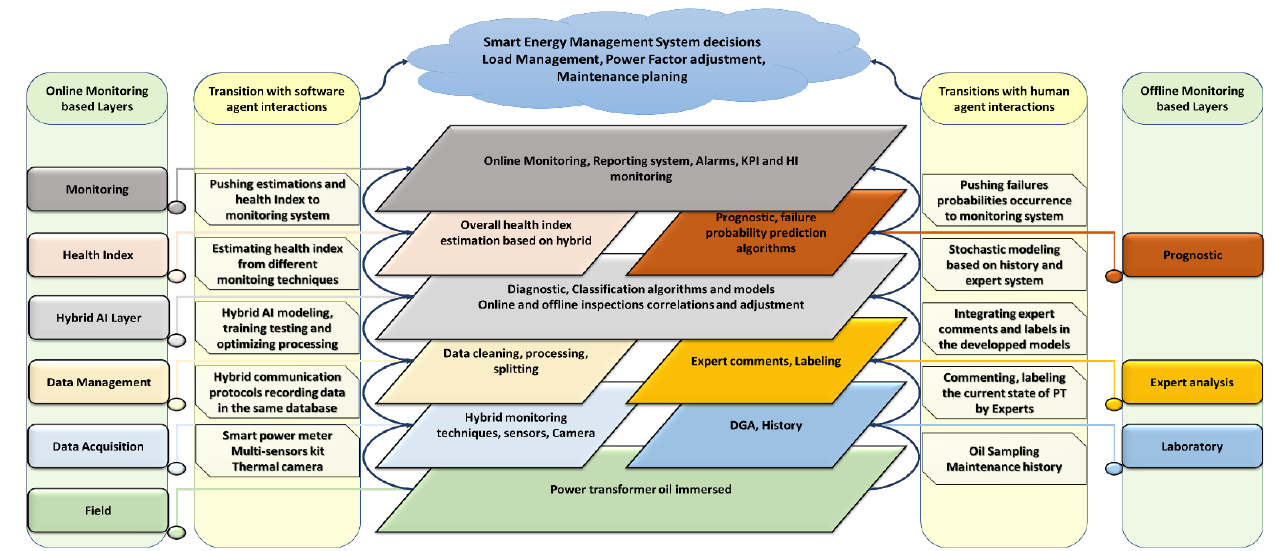
Figure 6. Hybrid AI multilayers architecture for prognostic health management.